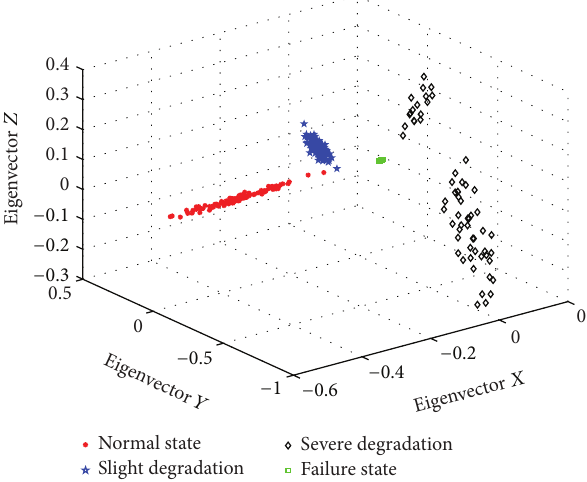
Figure 6: Space distribution of time-domain features.